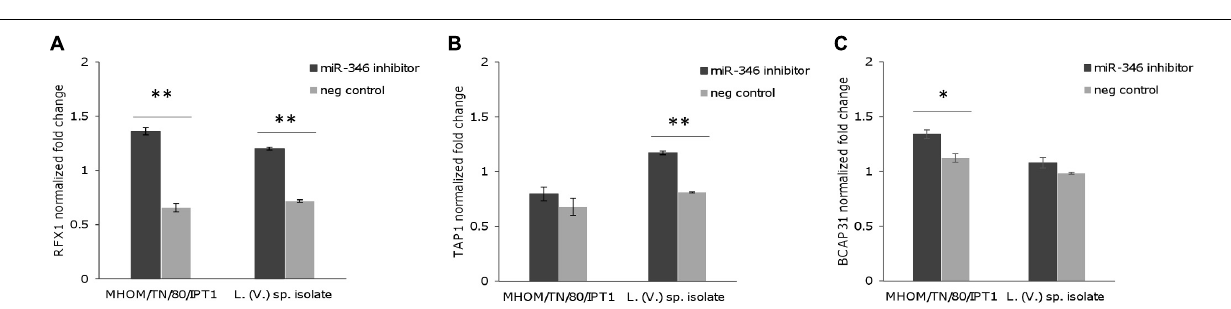
FIGURE 5 | Expression of predicted miR-346 target genes in infected THP-1-derived macrophages transfected with miR-346 inhibitor. (A–C) Relative mRNA levels of RFX1 (A) , TAP1 (B) , and BCAP31 (C) were evaluated in THP-1-derived macrophages after 48h infection with L. ( L. ) infantum MHOM/TN/80/IPT1 strain and L. ( V. ) sp. isolate. Before infection, cells were transfected with the miR-346 inhibitor (dark gray bars) or with the miRNA inhibitor negative control (light gray bars) ( n = 4). Expression levels were normalized against transfected non-infected cells. ∗ p < 0.05; ∗∗ p <